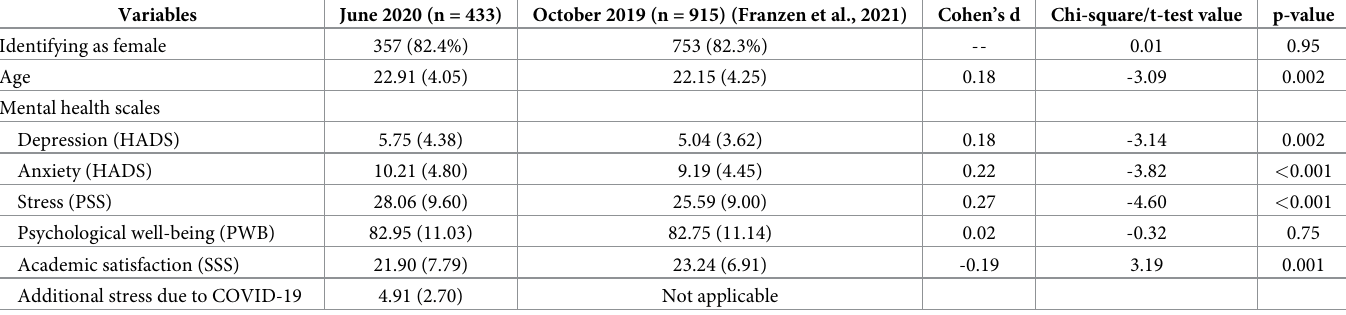
Table 1. Gender identity, age, health disciplines, and questionnaires scores (means (sd)), and comparison between June 2020 and October 2019 (Franzen et al., 2021).